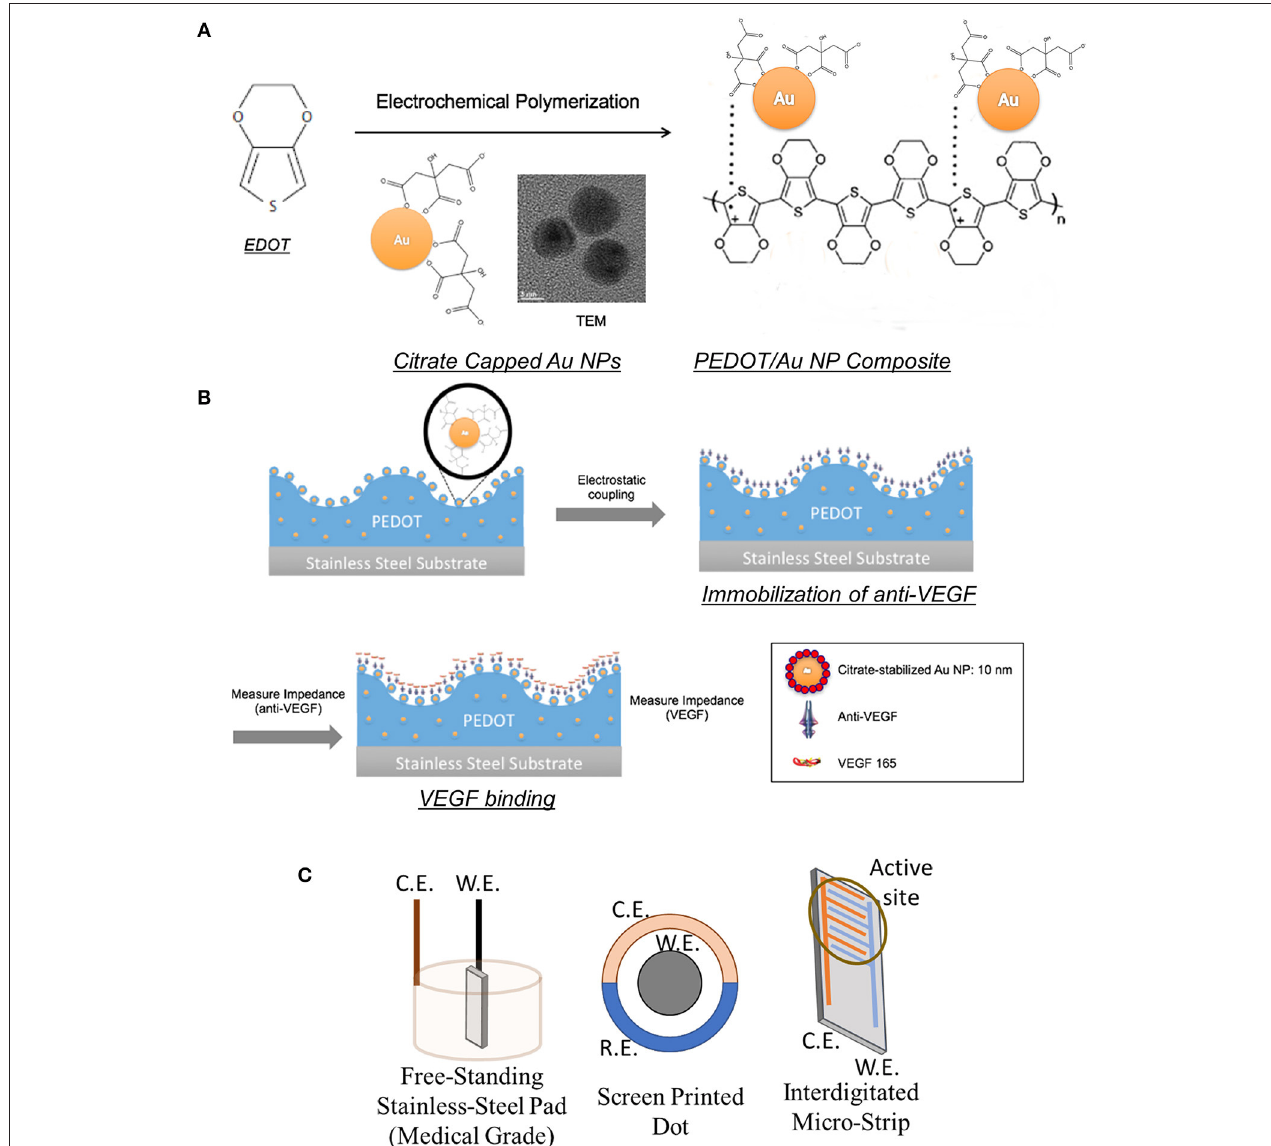
FIGURE 1 | Schematics of PEDOT/Au NP composites for VEGF sensors: (A) Electrochemical polymerization of PEDOT/Au NP composites (B) Anti-VEGF immobilization and VEGF binding (C) Configurations of working (W.E.), counter (C.E.), and reference (R.E.)